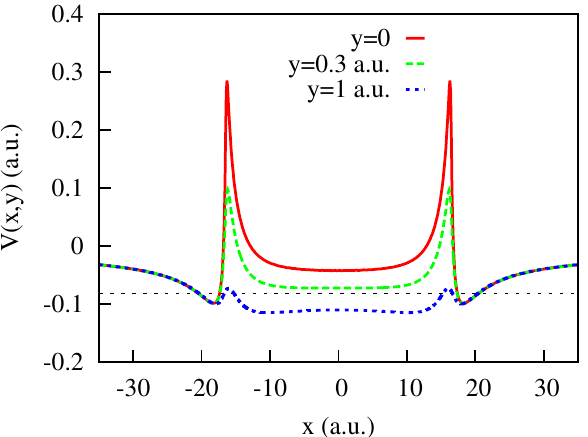
Figure 8. Cuts of the KH potential U ( x , y ) for different y for the IR field strength E 0